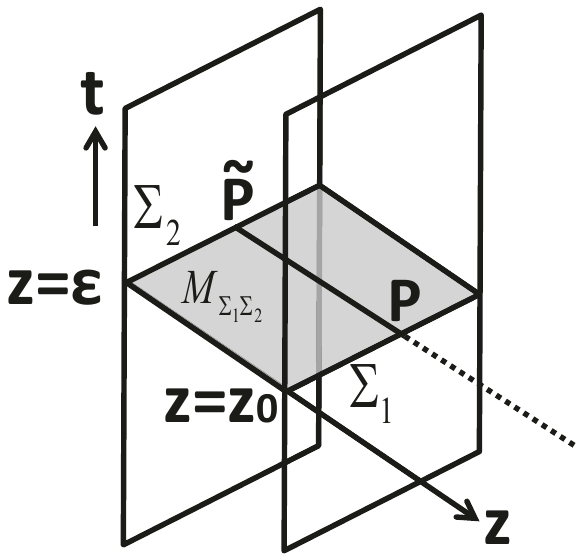
Figure 9 . An examples of space-like path-integration in a Poincare AdS 3